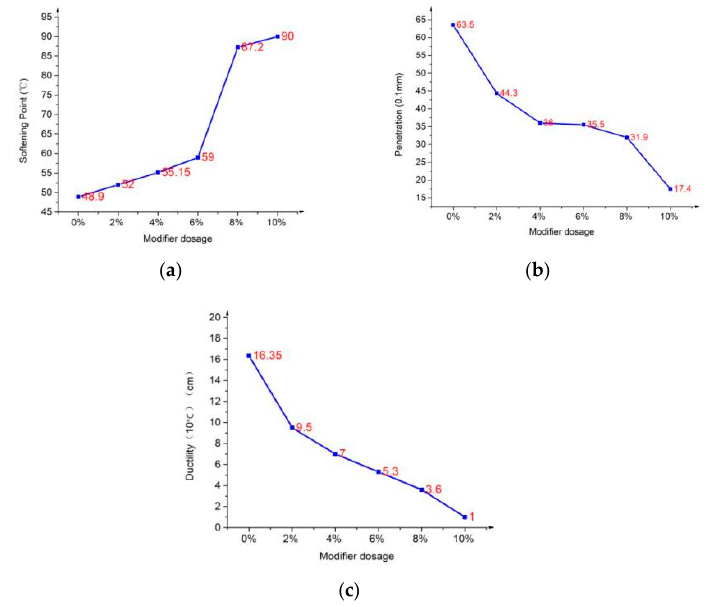
Figure 2. The three empirical characteristics: ( a ) softening point; ( b ) penetration; ( c ) ductility.